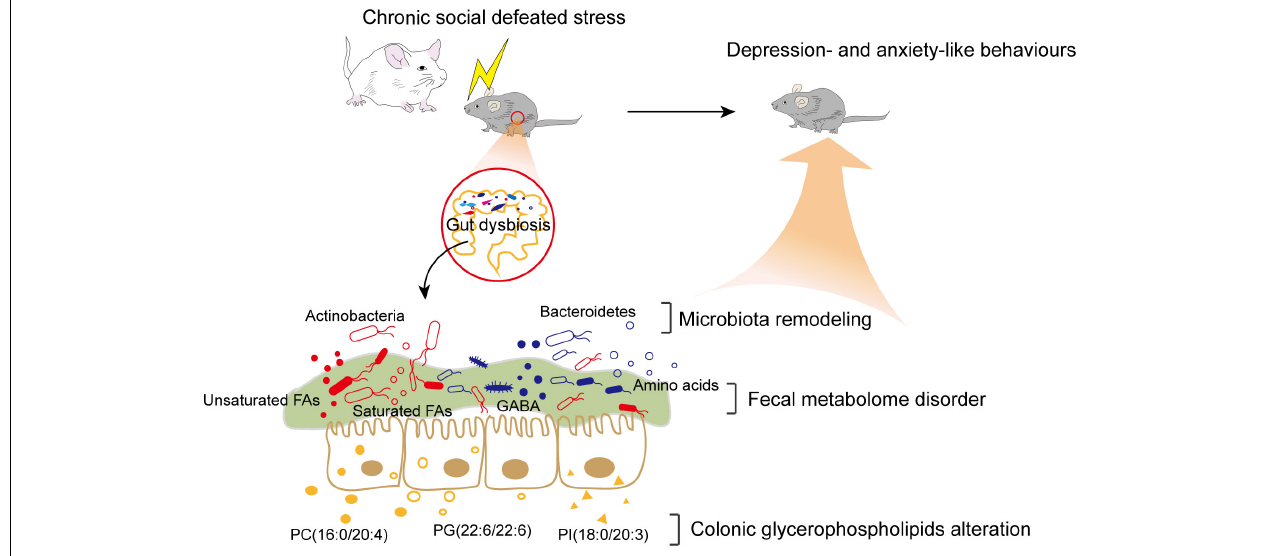
FIGURE 6 | Brief summary of the study. CSDS induced gut microbiota remodeling and alterations of the fecal metabolome and colonic lipidome in C57BL/6J mice. The interactions among differential bacteria taxa, fecal metabolites, and colonic lipids might contribute to the potential mechanism of the MGB axis in the pathogenesis of